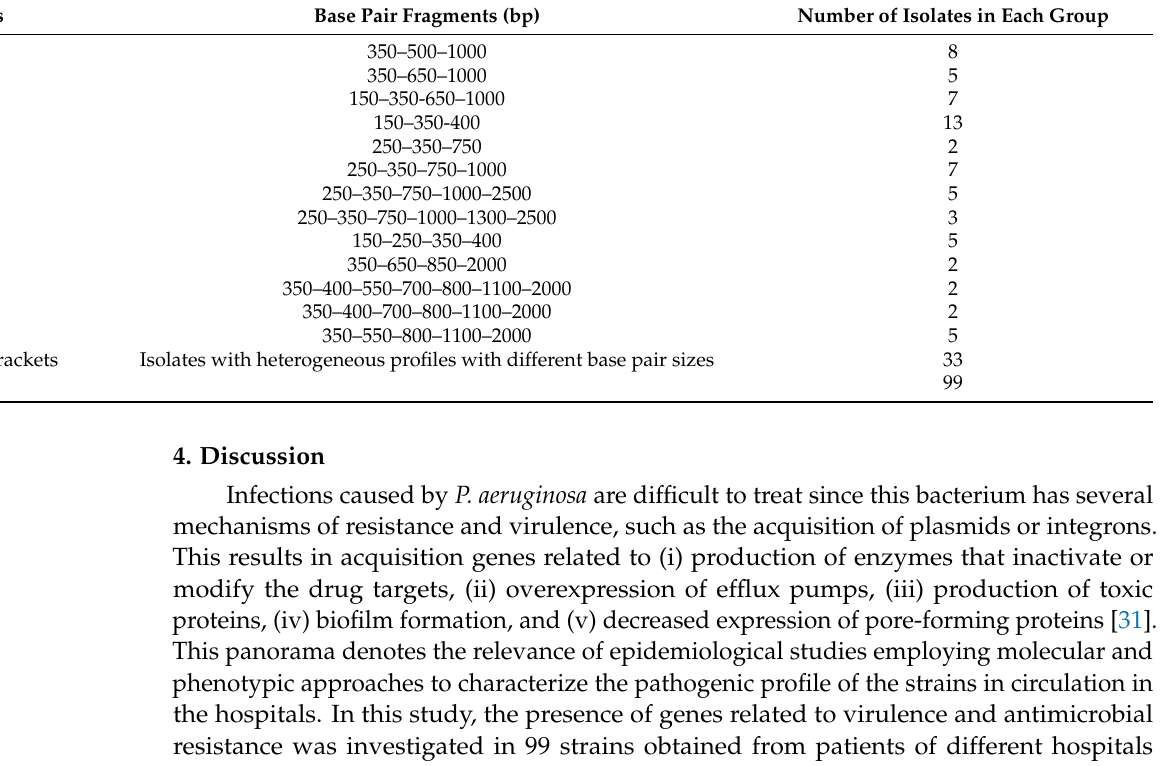
Figure 3. Dendrogram of genetic similarity derived from the DICE similarity coefficient showing the relationships between Pseudomonas aeruginosa isolates. Construction made using the NTSYS program with the Unweighted Pair Group Method with Arithmetic Mean (UPGMA) algorithm. Table 7. Profiles of groups of fragments and number of isolates in each clade formed by multivariate analysis using NTSYS.